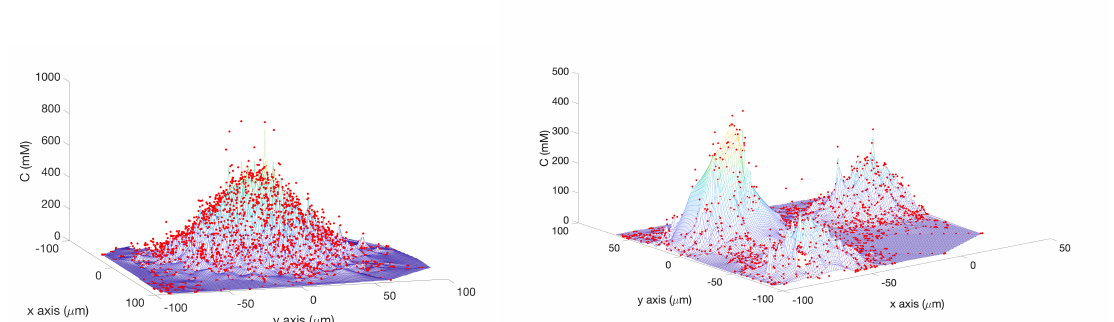
Figure 8. Left : Interpolated surface of concentration C to show how the raw sensor reading (shown as red dots) was calibrated via Equation (2) at different locations on the single-effluent poster shown in Figure 4b. Right : Interpolated surface of concentration C to show how the raw sensor reading (shown as red dots) was calibrated via Equation (3) at different locations on the triple-effluent poster shown in Figure